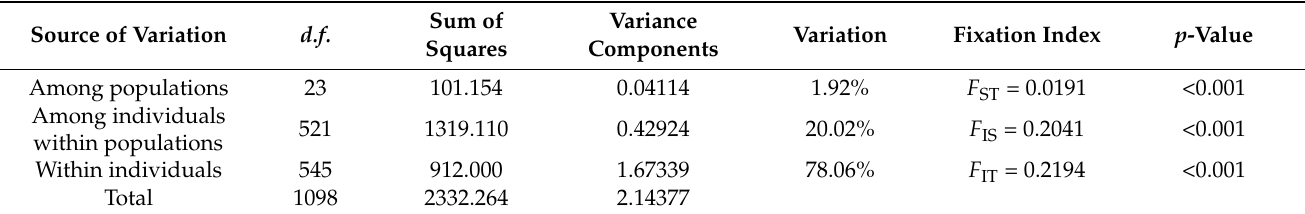
Table 3. AMOVA analysis for genetic variation of 24 populations of S. litura